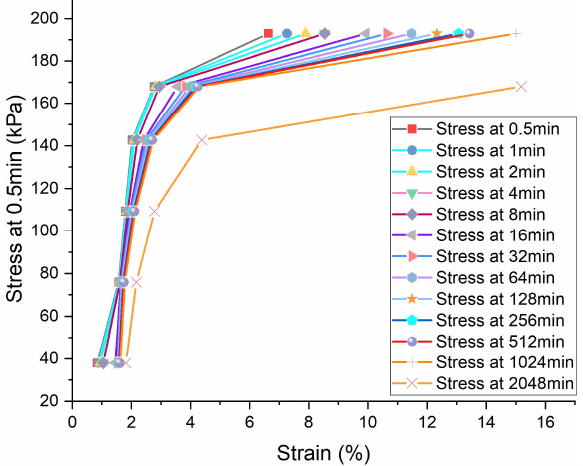
− σ ) - ( ε ) curves of Specimen No. 12, 4 FTHs. 3 1 1